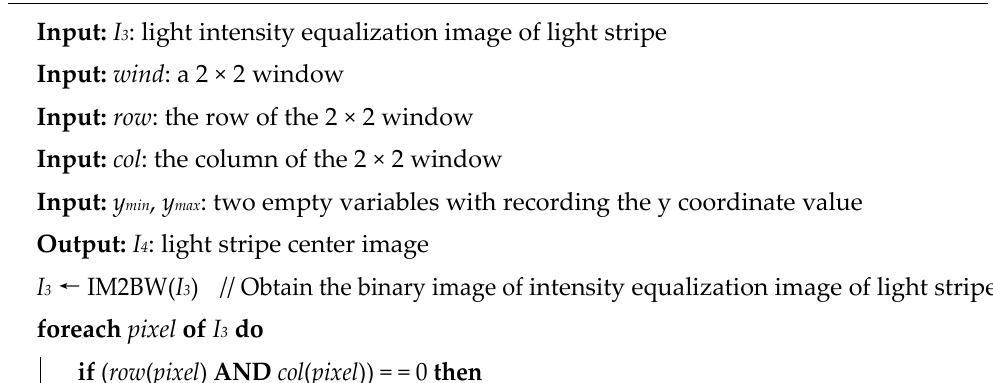
Algorithm 2: Pseudo-code of Adaptive Window Algorithm of Light Stripe Center Extraction